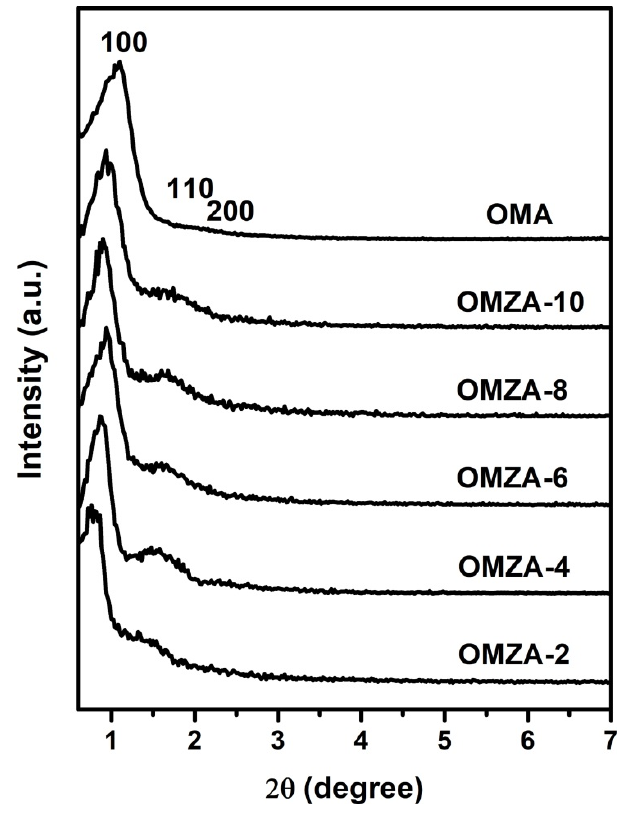
Figure 2. Small-angle X-ray diffraction (XRD) patterns of samples OMZA-x and OMA.